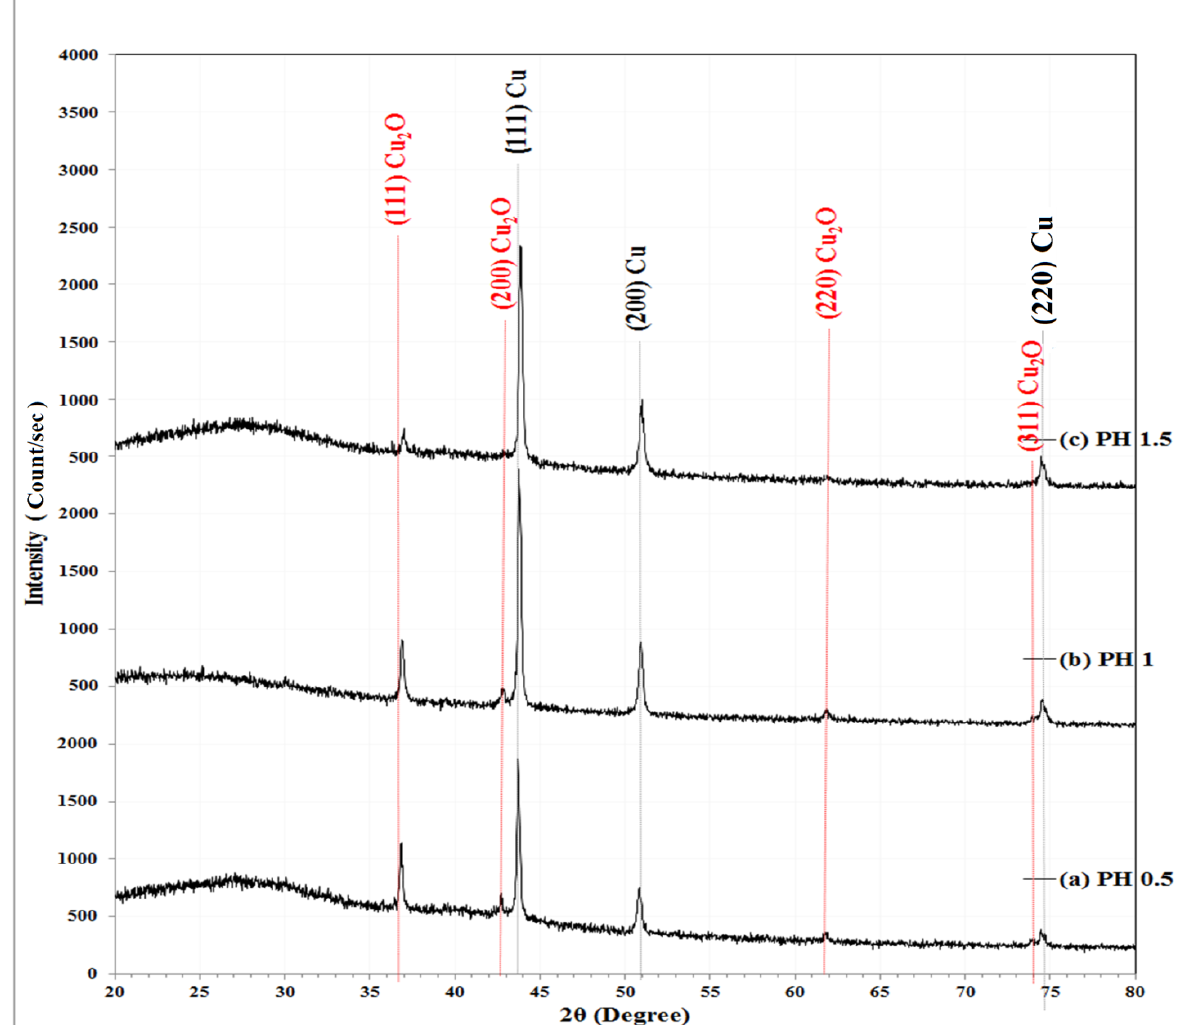
Fig. 2: XRD spectra of CuNPs produced by electrochemical sonication of CuSO a) 0.5, b)1.0 and c)1.5 for 1min with sonication power of 400